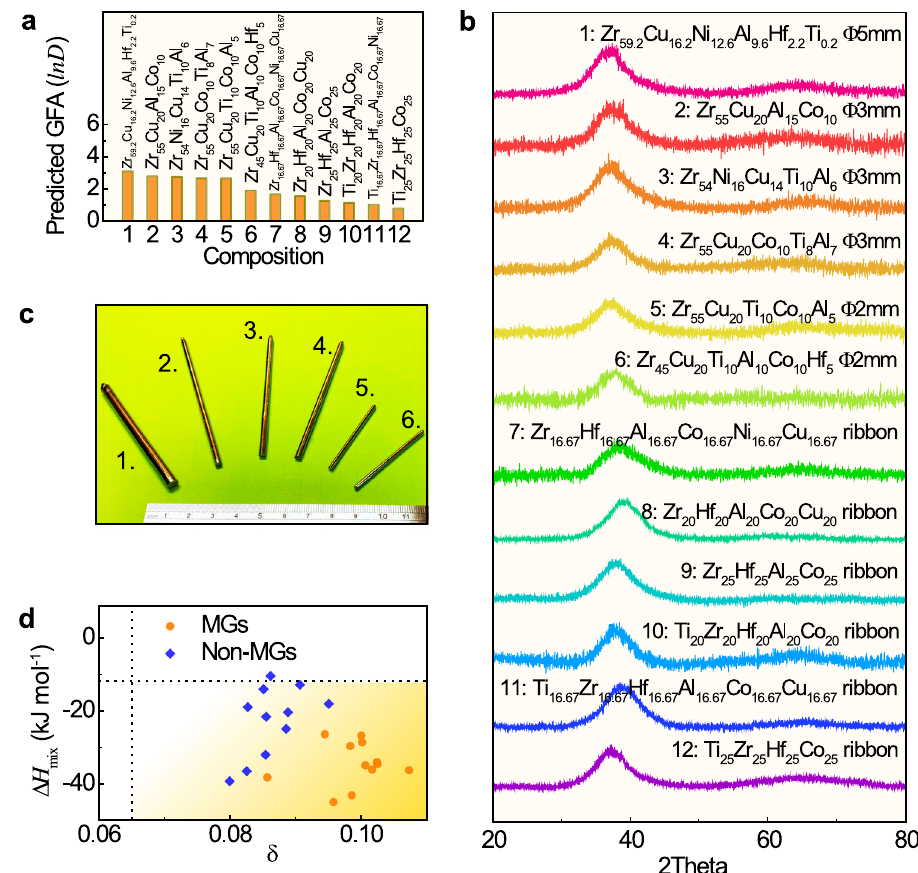
Fig. 3 ML-guided design of chemically complex metallic-glasses. a The RQGPR predicted GFA values of the 12 glass-forming alloys. b The XRD spectra con fi rming the glassy structure. c Appearance of 6 BMGs. d Plot of our 23 alloy compositions in the Δ H mix - δ diagram.